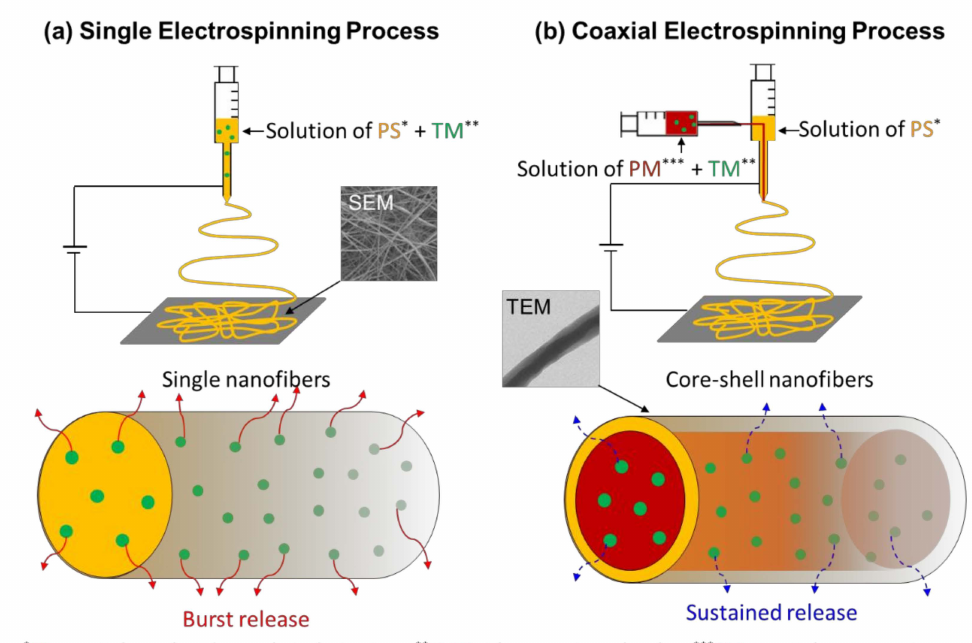
Figure 4. Schematic illustrations of encapsulations of therapeutic molecules via ( a ) a single electro- spinning process and the resulting single nanofibers that show a burst release profile, and ( b ) a coaxial electrospinning process and the resulting core–shell nanofibers that show a sustained release